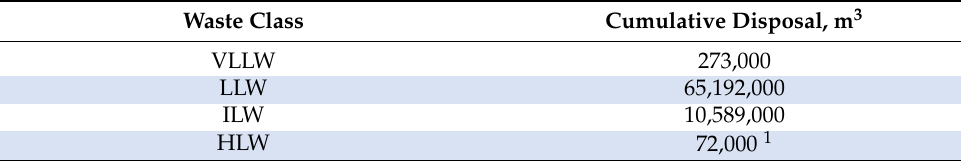
Table 8. Global estimate inventory for 2014 of radioactive waste disposed